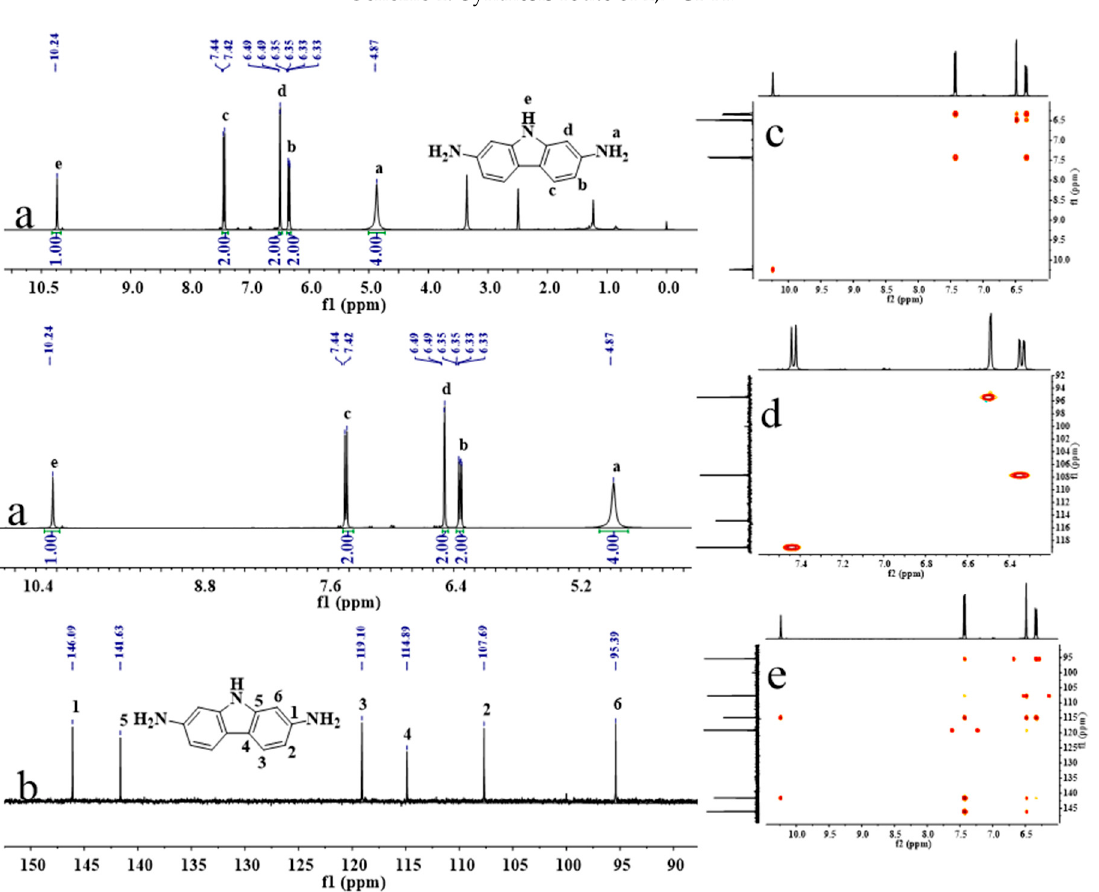
Figure 2. ( a ) 1 H NMR (above: the spectra in the range of 0~11; below: the partial enlargement in the range of 4.5~11), ( b ) 13 C NMR, ( c ) H-H COSY, ( d ) C-H QC and ( e ) C-H BC spectra of 2,7-CPA in DMSO- d 6 .